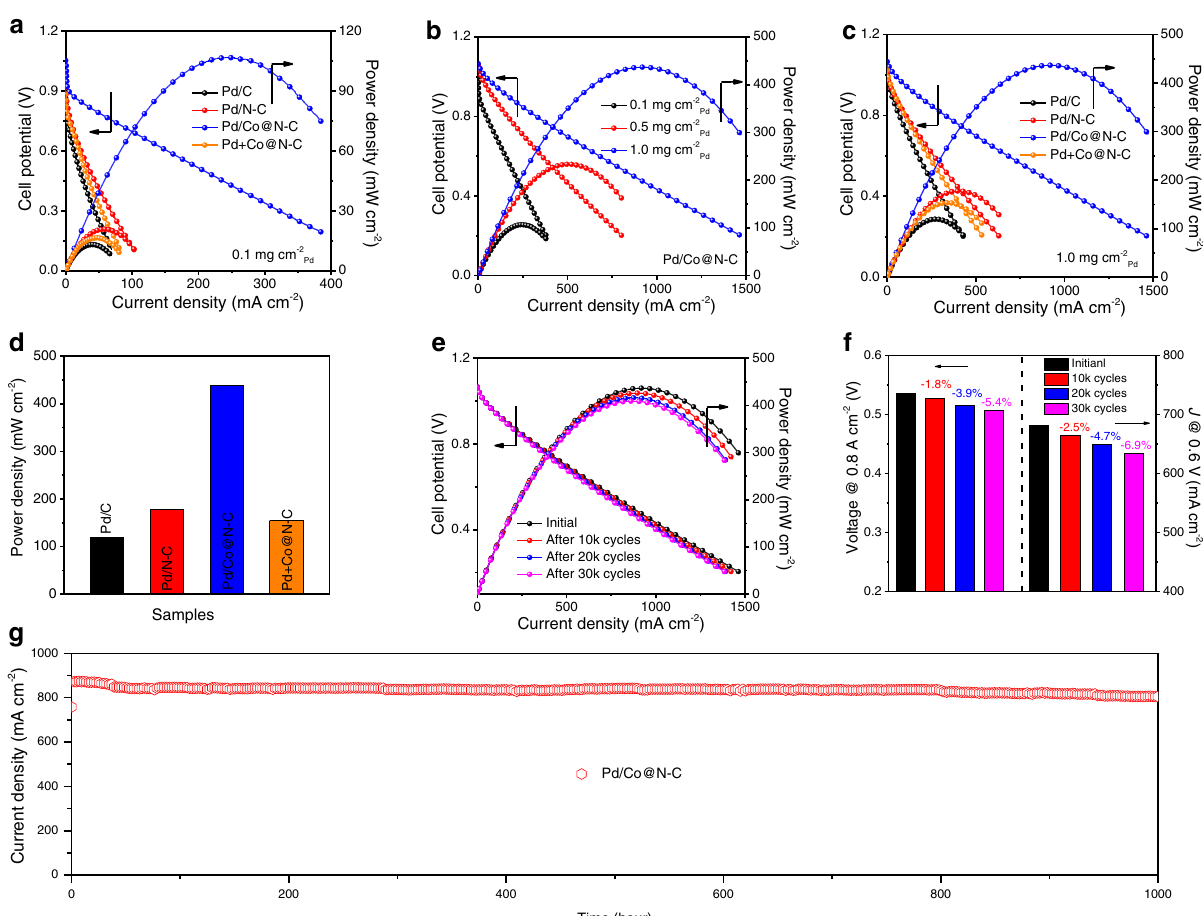
Fig. 6 | Synergistic interface effect of Pd/Co@N-C for DEFCs performance. a Steady-state DEFCs polarization and power density curves using different cata- lysts with a Pd loading of 0.1mgcm − 2 on MEA. b Steady-state DEFCs polarization and power density curves using Pd/Co@N-C with different Pd loading on MEA. c Steady-state DEFCs polarization and power density curves using different cata- lysts with a Pd loading of 1.0mgcm − 2 on MEA. d The maximum power density of DEFCs using different catalysts with a Pd loading of 1.0mgcm − 2 on MEA. e Steady-